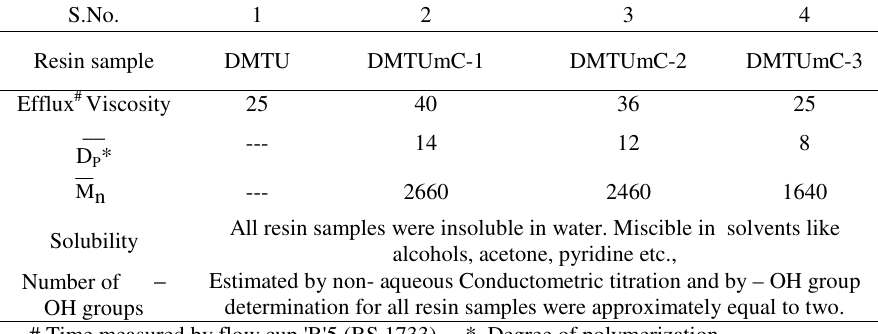
Table 2 . Physical parameters of N,N'-Dimethylolthiourea and N,N'-Dimethylolthiourea –